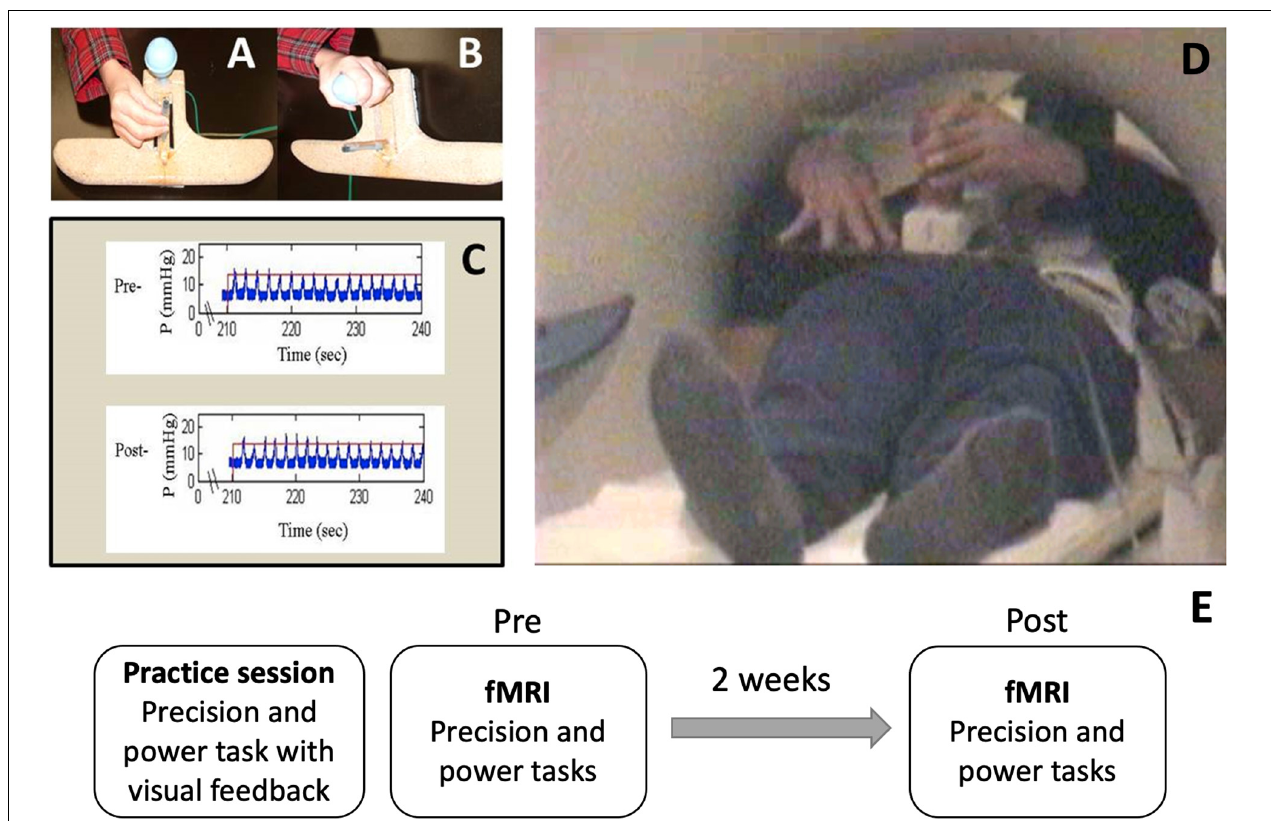
FIGURE 1 | Motor Activation Tasks performed in the functional magnetic resonance imaging (fMRI) scanner. Task apparatus MRI safe device with two pneumatic pressure sensors for (A) precision grip and (B) power grasp. (C) Sample pre- and post-pressure and rate graphs demonstrating participant ability to maintain 50% of their predetermined maximum pressure and 75% of their predetermined maximum rate throughout each fMRI session. (D) Participants were positioned to minimize movement within the scanner. No visual feedback was offered during the scan. (E) Study